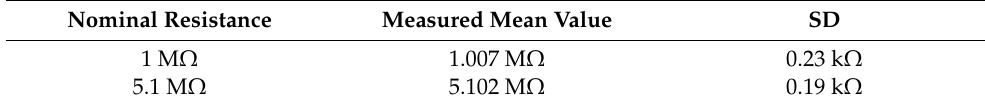
Table 2. Repeatability characterization of the prototype device ( n = 11).